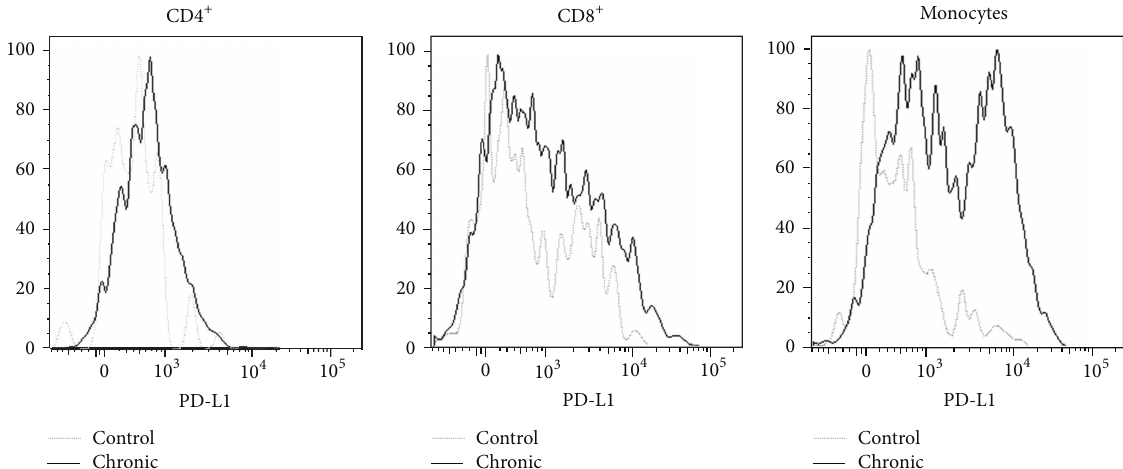
Figure 1: Expression of PD-L1 by infiltrating leukocytes in a chronically infected heart. C3H/HePAS mice were infected with 4 × 10 5 Sylvio X10/4 trypomastigotes obtained from LLCMK2 cultures. At day 400 postinfection, mice were sacrificed, and the heart tissue was digested with collagenase to isolate the infiltrating leukocytes. PD-L1 expression was analyzed by flow cytometry. Heart leukocytes from a pool of age-matched noninfected mice were also